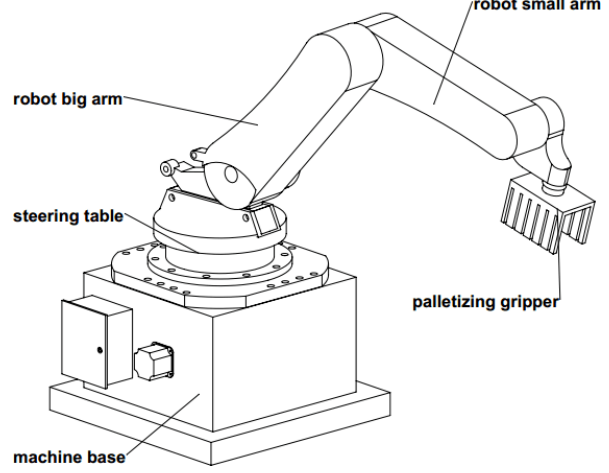
Figure 6. 3D sketch of the palletizing robot.